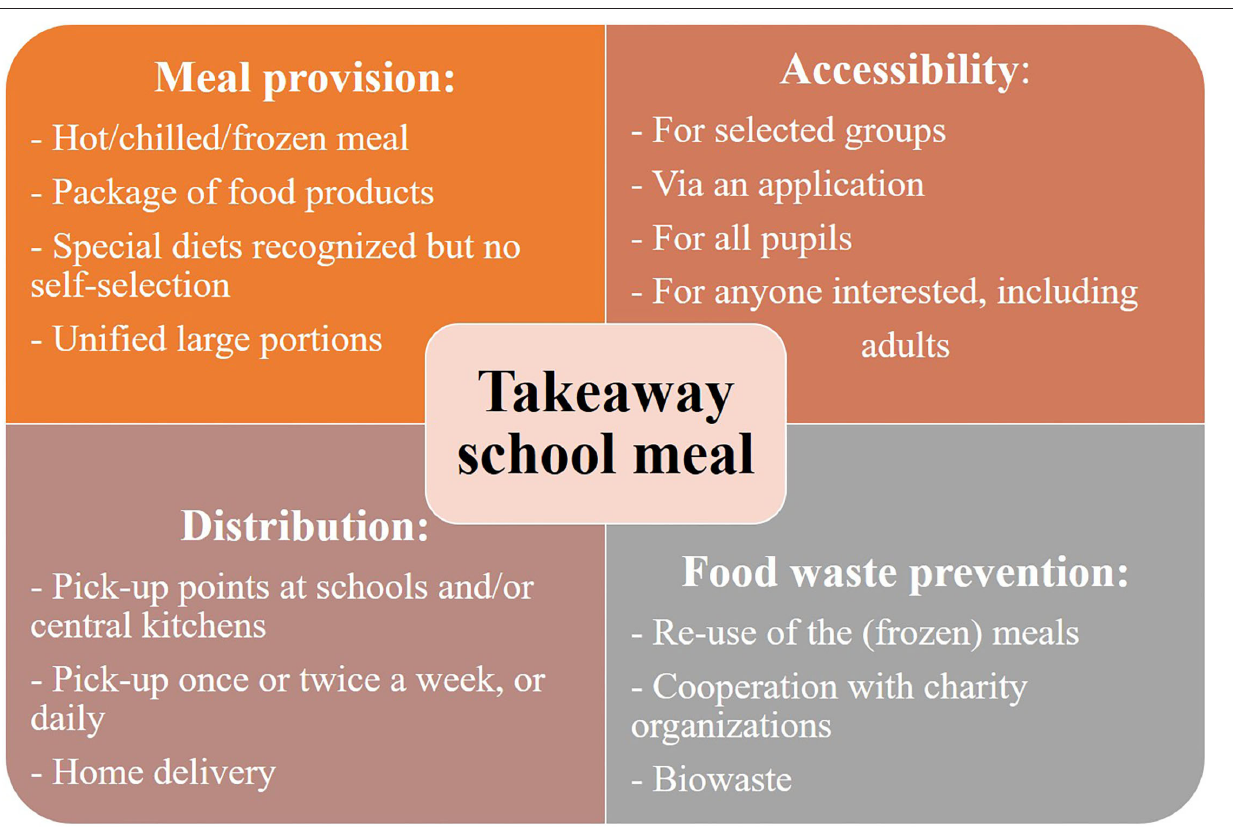
FIGURE 6 | The characteristics of the takeaway school meal model evolved during the COVID-19 pandemic in the BSR countries. Source: own analysis based on interviews and collected